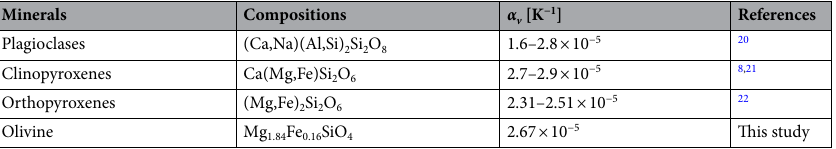
Table 4. Volume thermal expansion coefficients. Volume thermal expansion coefficients, α v , for the main constituent phases of planetary